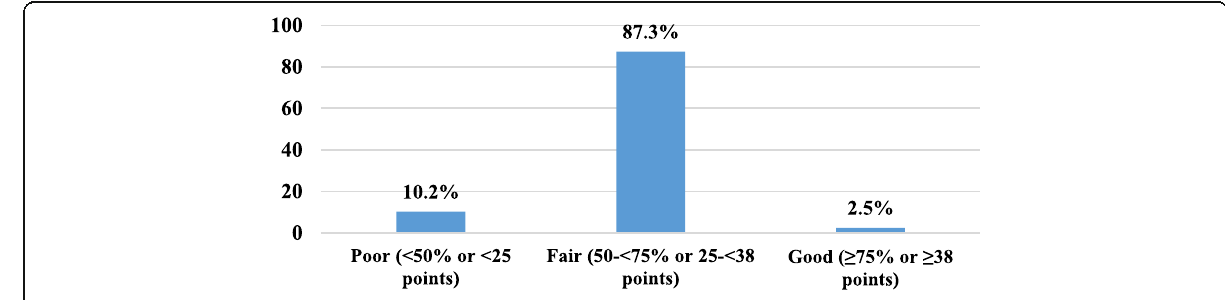
Fig. 1 Level of knowledge of caregivers regarding infectious diseases and infection control measures (Alexandria,